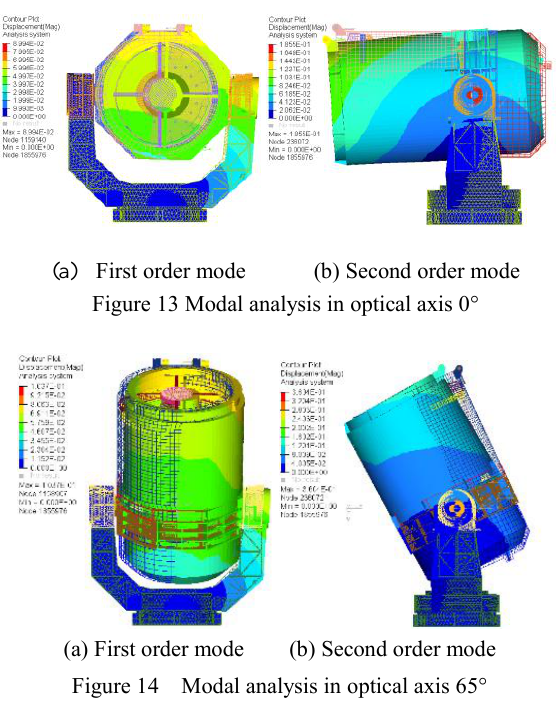
2.4 Two-Dimension Rotate Platform Scheme